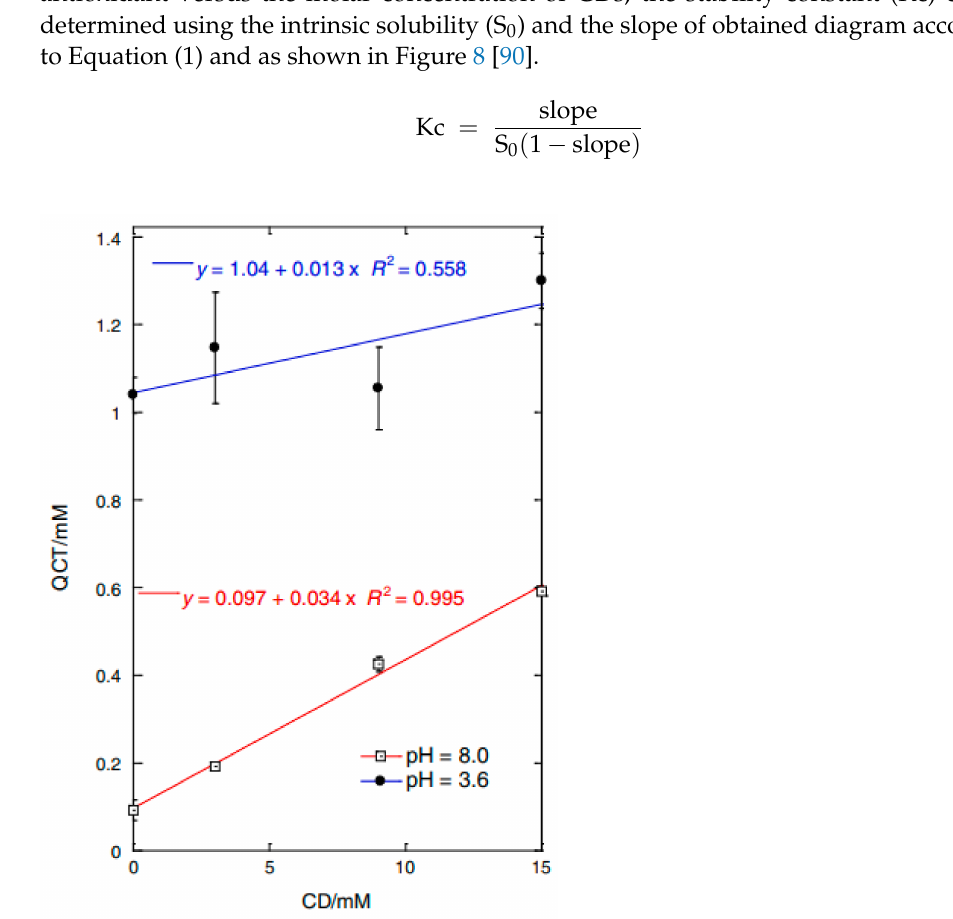
Figure 8. Phase solubility graph of QCT with HP- β -CD in phosphate (pH = 8.0) and citrate (pH = 3.6) buffers